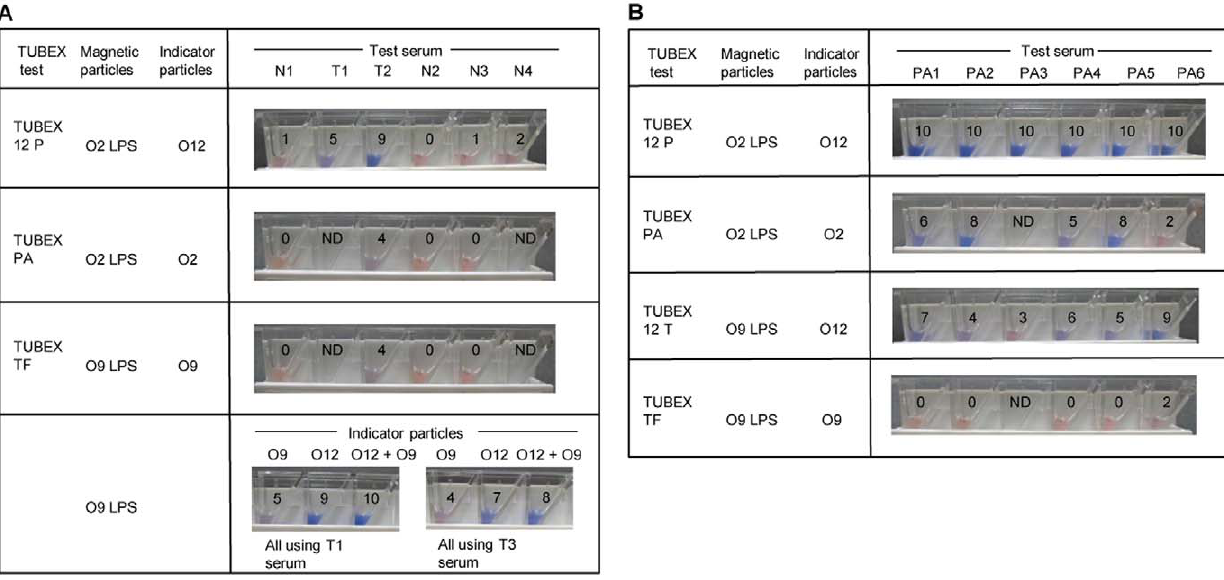
Figure 3. Pictoral results showing efficacy of various TUBEX tests in detecting clinical samples. Sera obtained from typhoid (A) or paratyphoid A (B) patients, or from healthy individuals (A), were examined as described in Figure 2. N1-N4, healthy individuals; T1, typhoid individual; T2, pool of 4 typhoid patients; T3, pool of 4 other typhoid patients; PA1-PA6, paratyphoid A patients; numericals in microwells denote TUBEX scores; ND, not done (insufficient specimen).